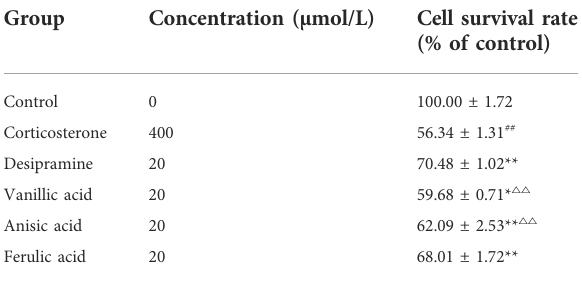
TABLE 2 Protective effect of compounds on corticosterone-induced PC12 cells.